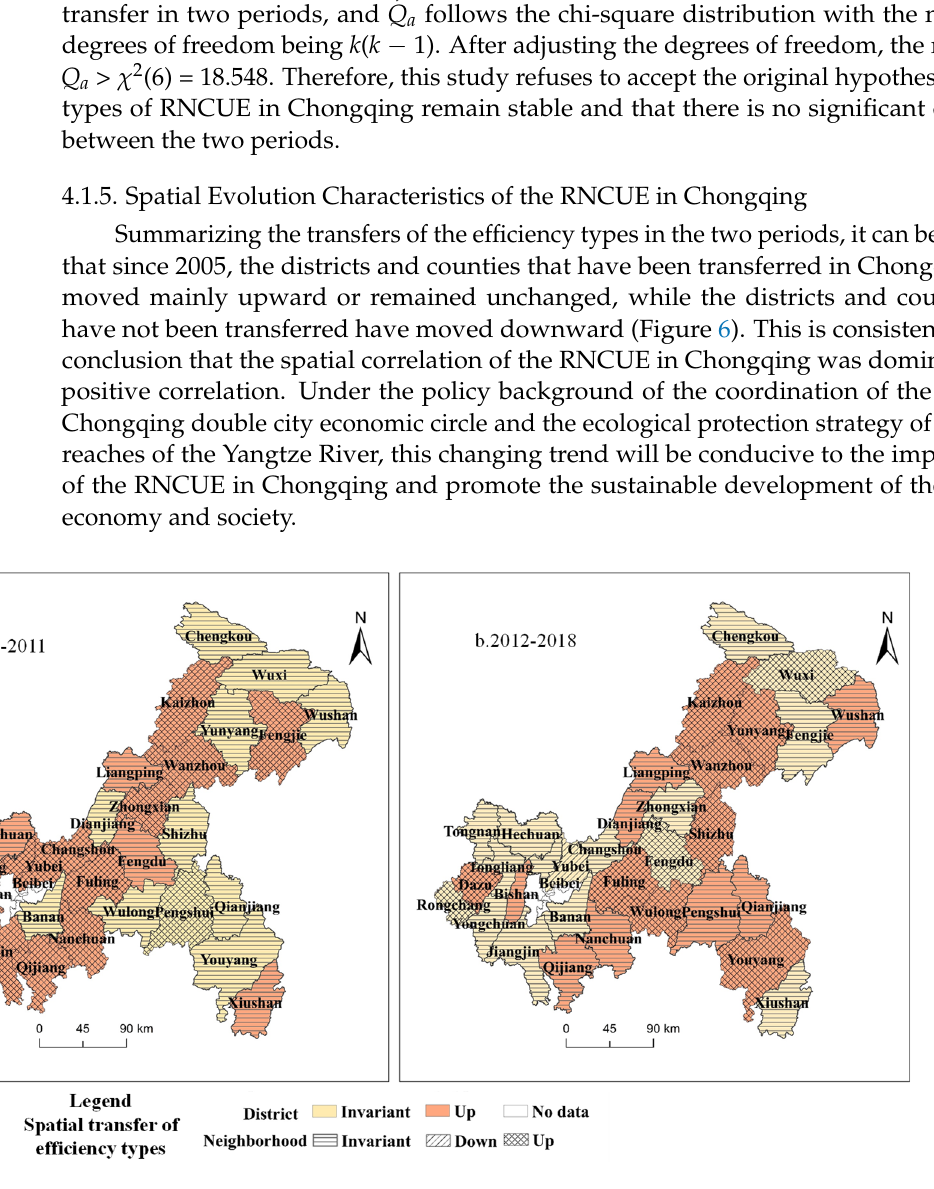
Figure 6. Spatial distribution pattern of the RNCUE type transfers and neighbourhood transfers in Chongqing from 2005 to 2018. ( a ) 2005–2011; ( b ) 2012–2018. Chongqing from 2005 to 2018. ( a ) 2005–2011; ( b )